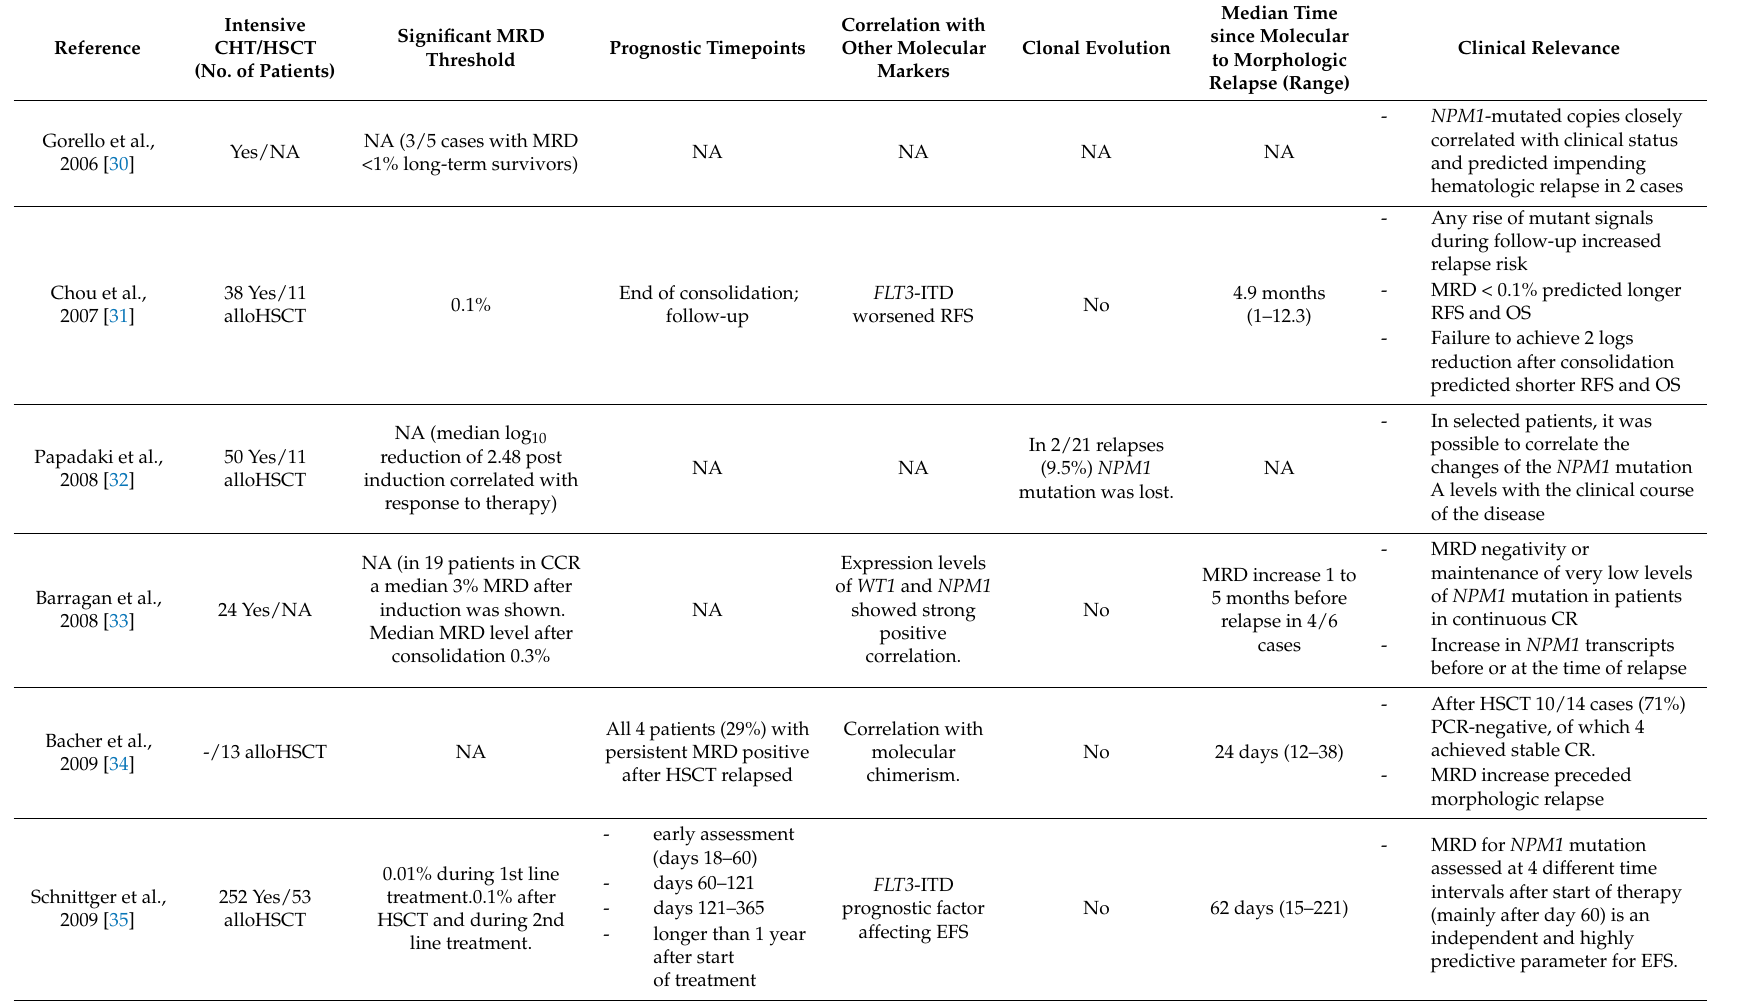
Table 2. Clinical impact of MRD monitoring in NPM1 -mutated AML